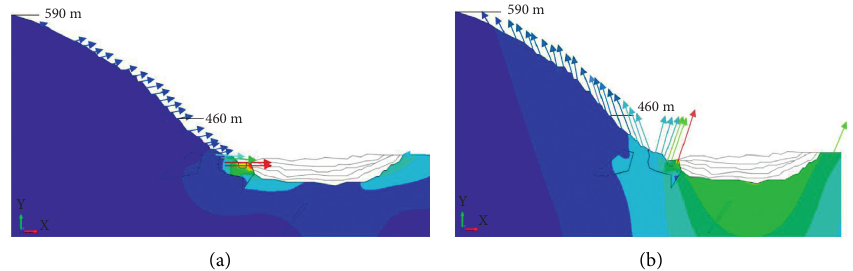
Figure 14: Examples of total displacement vector at the surface of rock slope induced by excavation due to (a) release of horizontal stress and (b) gravity in 2019 at the blue dotted rectangle in Figure 8(b). The arrows indicate the directions of the displacement, whereas the length of the arrow is proportional to the magnitude of the displacement.